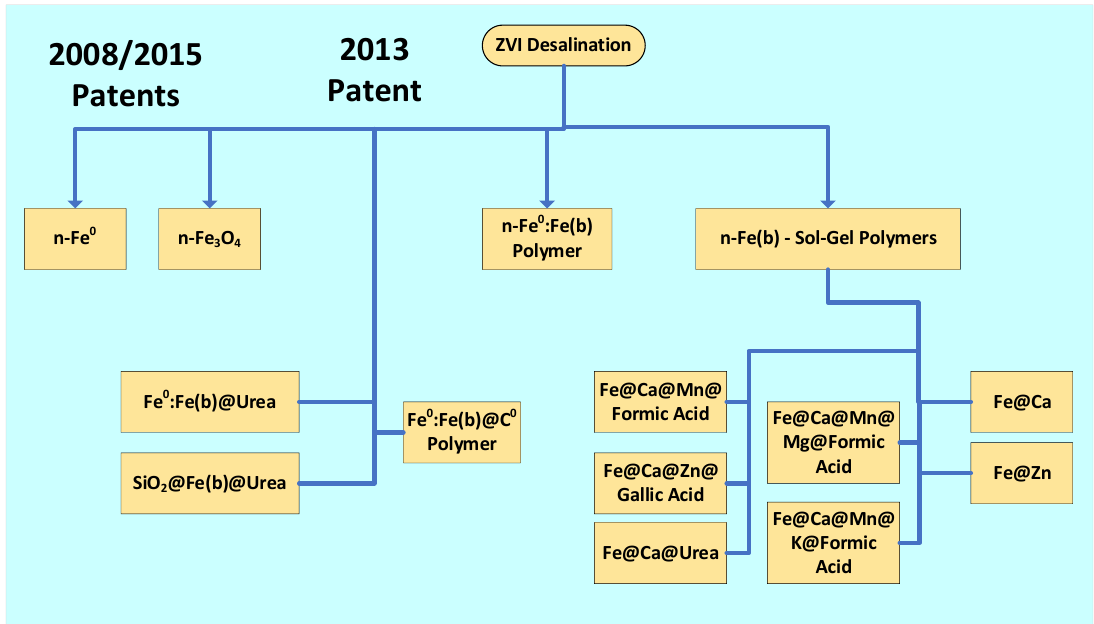
Figure 1. ZVI desalination approaches considered in this study. The n-Fe 0 and n-Fe 3 O 4 routes are addressed in Appendix D. The Fe 0 :Fe(b)@C 0 polymer routes are addressed in Appendix A, the n-Fe 0 :Fe(b) polymer routes are addressed in Section 3. The n-Fe(b) sol-gel polymer routes are addressed in Sections 4 and 5. The Fe 0 :Fe(b)@urea and SiO 2 @Fe(b)@urea polymers are addressed in